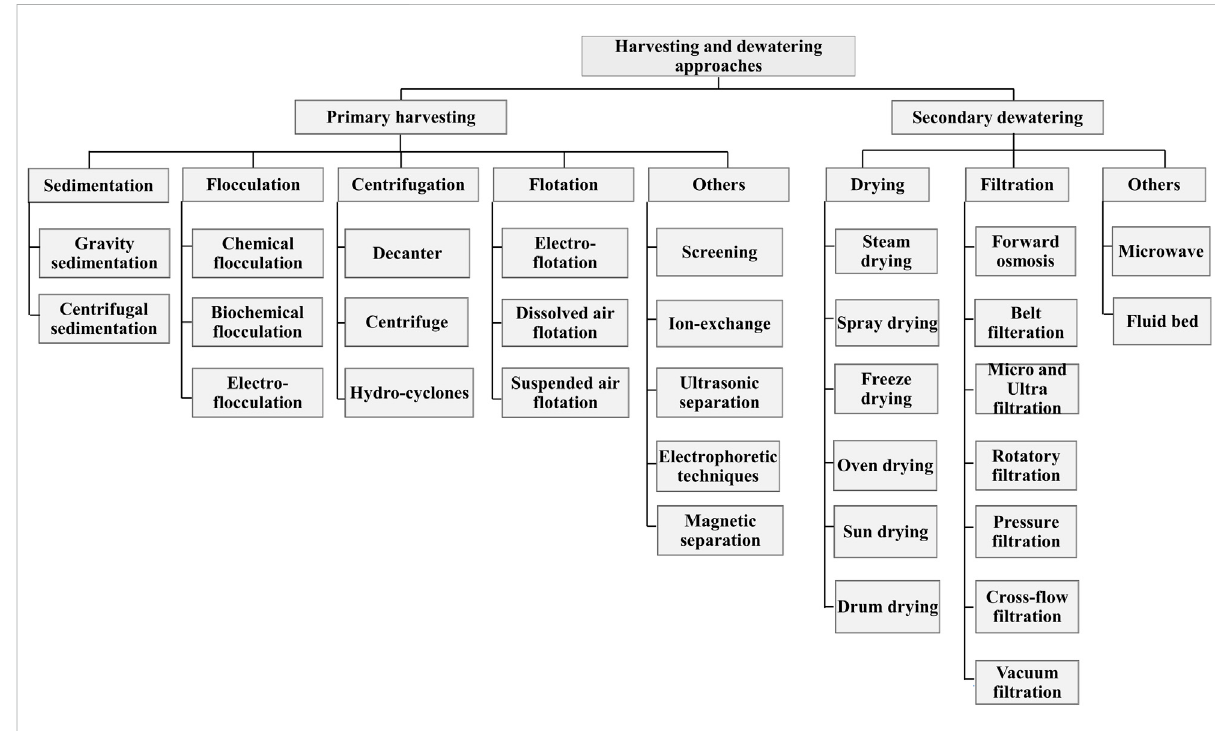
FIGURE 2 Various methodologies of harvesting and dewatering of cultivated microalgal